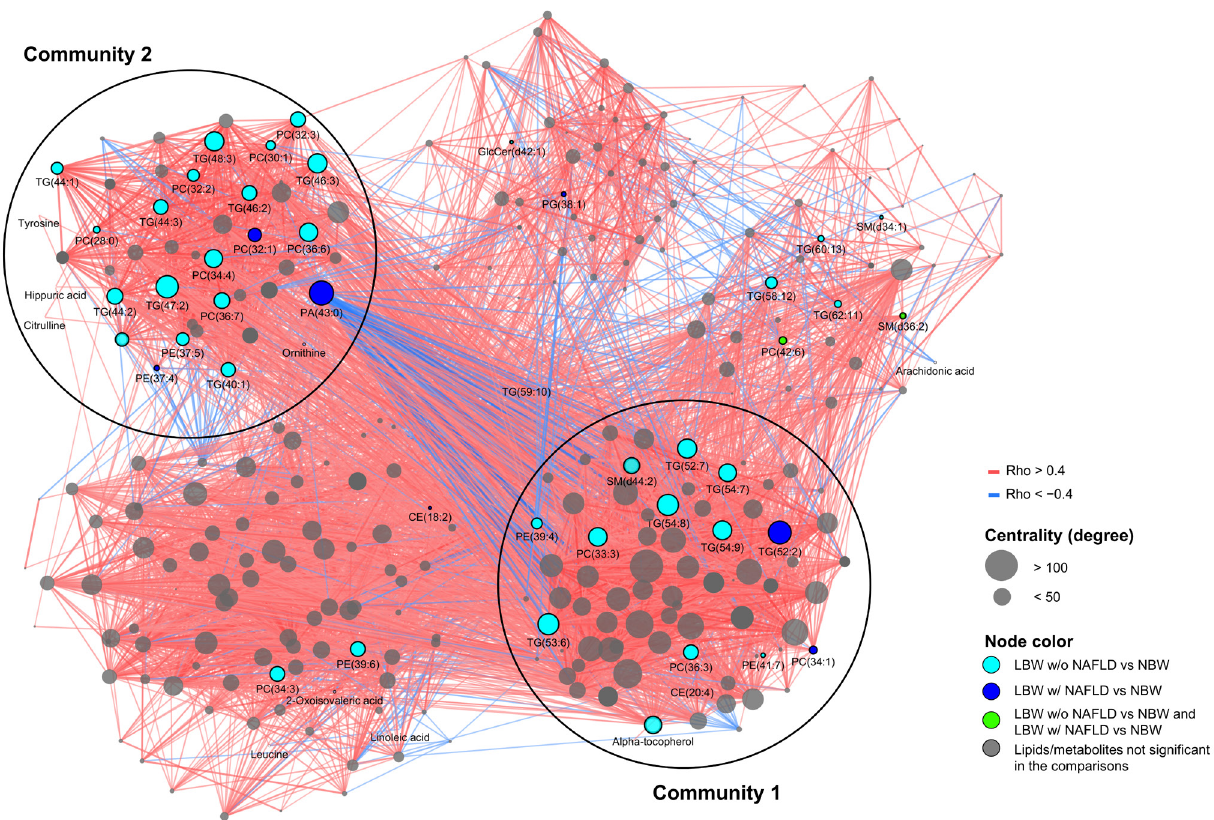
Figure 3. Correlation network of lipids and key metabolites. In the correlation network, nodes represent metabolites and lipids, and edges represent their correlations ([rho < −0.4; rho > 0.4], P FDR ≤ 0.1). Red edges indicate positive correlations, and blue, negative correlations. The size of each node corresponds to its centrality; thus, the bigger the node, the more correlated with other nodes it is. Colored nodes represent metabolites/lipids found to differentiate in NBW vs. LBW w/o NAFLD (light blue), NBW vs. LBW w/NAFLD (dark blue), and in both NBW vs. LBW w/o NAFLD and LBW w/NAFLD vs. NBW (light green). The two most important communities (C1 and C2) are visualized with black circles and text.